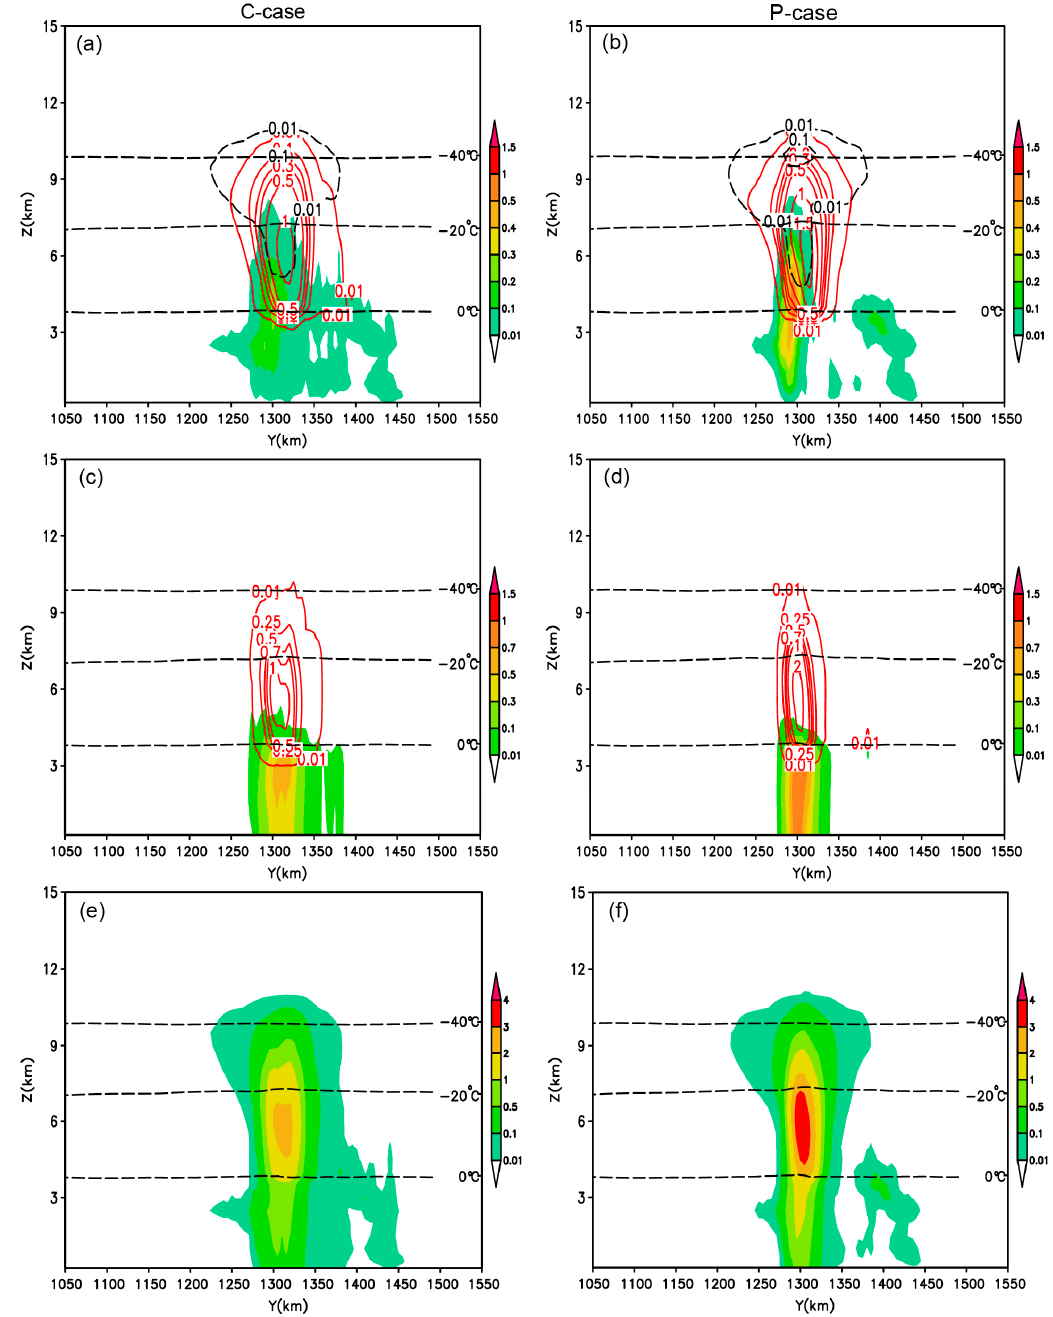
Figure 8. Vertical cross sections of zonal-mean mixing ratios (g kg − 1 ) of hydrometeors at t = 21 h ( a , b ) cloud water (shadow), ice crystals (black dashed line), snow (red solid line);( c , d ) rain water (shadow) and graupel (red solid line);( e , f ) the total hydrometeors contents (shadow). Only a 500 km × 15 km of the domain is presented. The left panels show C-case, the right panels show P-case.